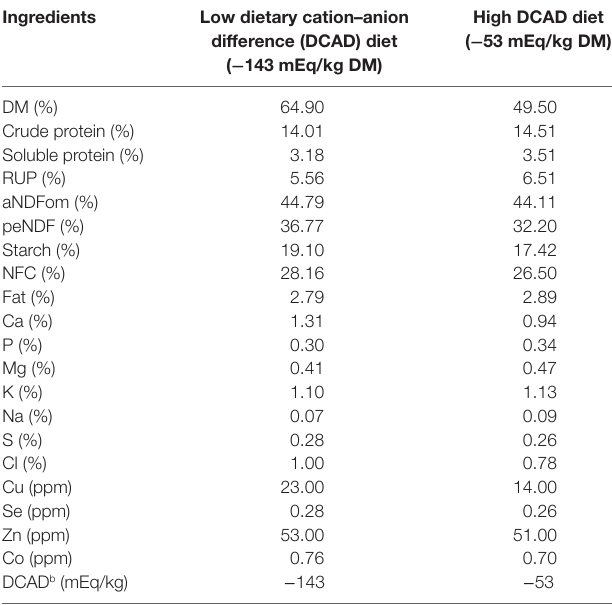
tabLe 2 | Nutritional composition of prepartum diets as dry matter (DM) basis using the nutritional Cornell Model (CNCPS 6.55). a